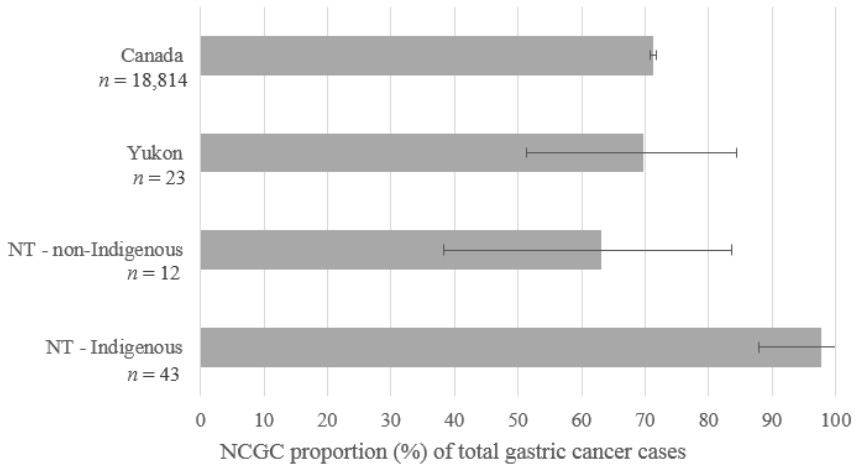
Figure 2. Proportional NCGC incidence (NCGC cases divided by total gastric cancer cases); northern territories, Canada; various years. Canada and Yukon include cases diagnosed 2003–2012; Northwest Territories (NT) includes cases diagnosed 1997–2015. Non-cardia gastric (NCGC) defined as C16.1-9. 95% confidence intervals are based on the binomial exact distribution.